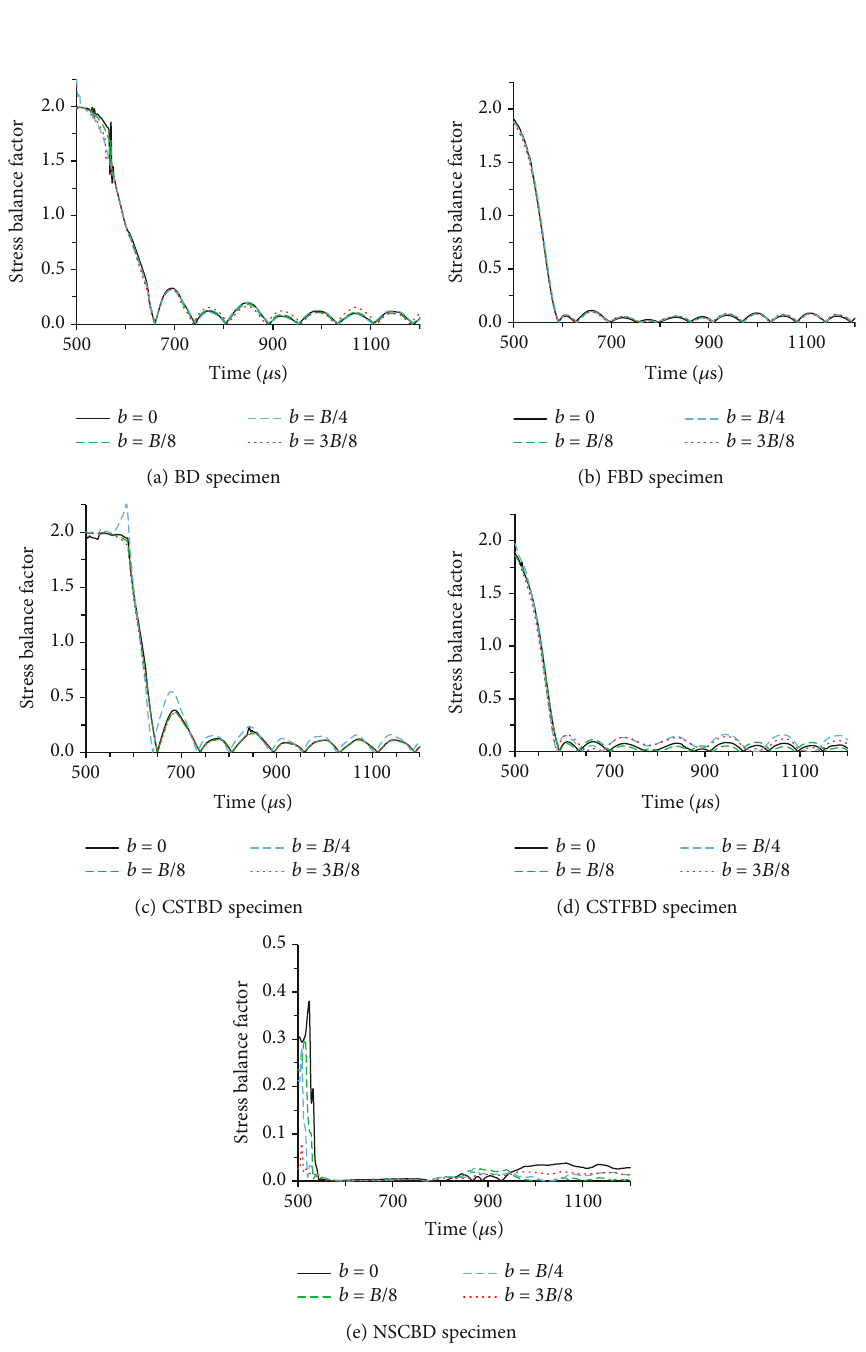
Figure 13: Stress balance factor curves for fi ve types of disc specimens at di ff erent